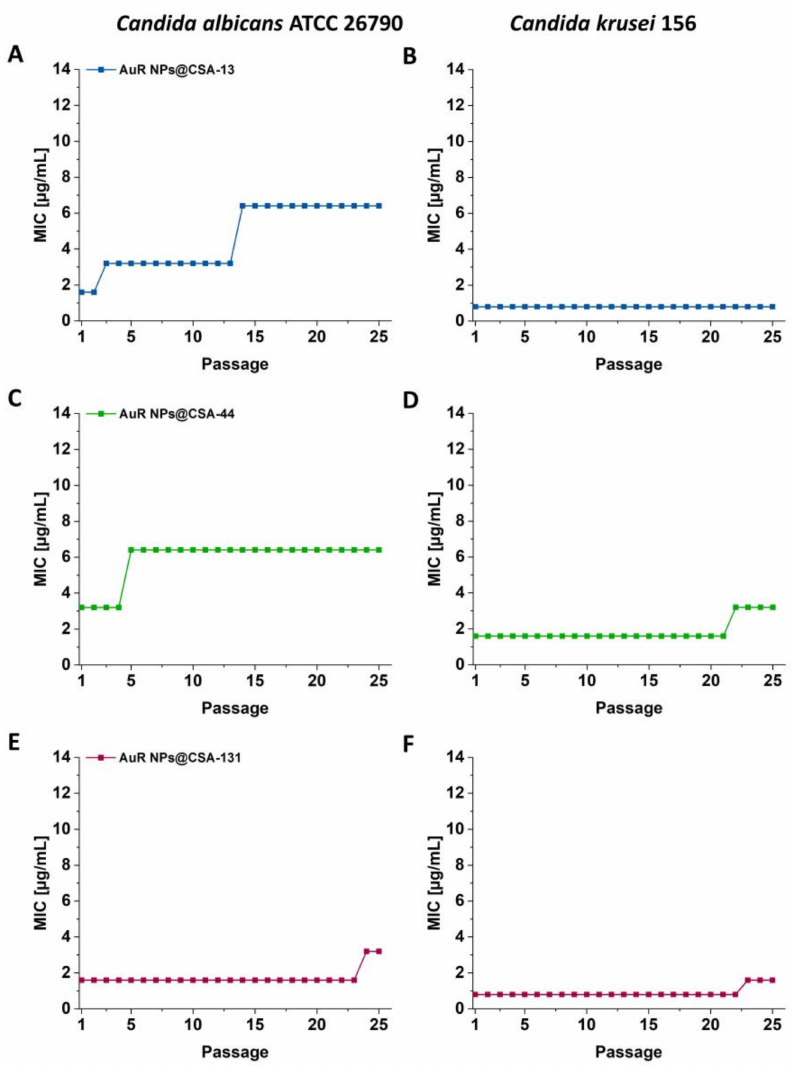
Figure 3. MIC/MFC values for C. albicans 26790 ( A , C , E ) and for C. krusei 156 ( B , D , F ) of the